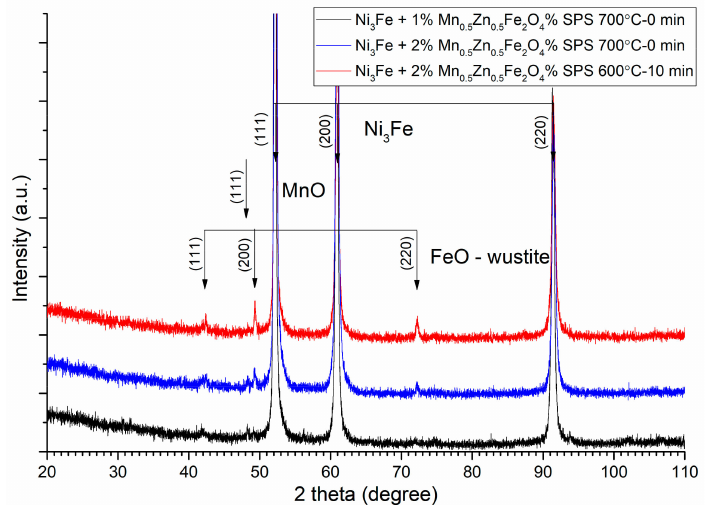
Figure 10. XRD patterns of the Ni3Fe/Mn0.5Zn0.5Fe2O4 composite compacts with 1 and 2 wt.% of MnZn ferrite obtained by SPS at sintering temperatures of 600 and 700 ◦ C and sintering time of 0 min and 10 min. For clarity, the XRD patterns have been shifted vertically.